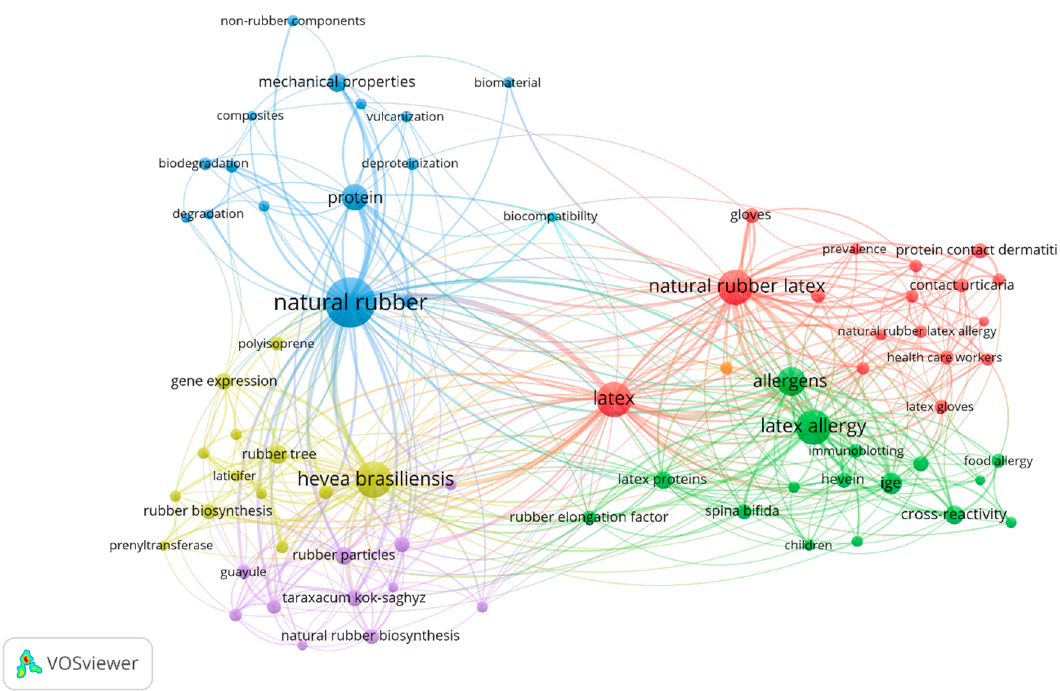
Figure 2. Bibliometric map of author keywords in publications on DPNR. Six theme groups: yellow, blue, green, purple, and red.